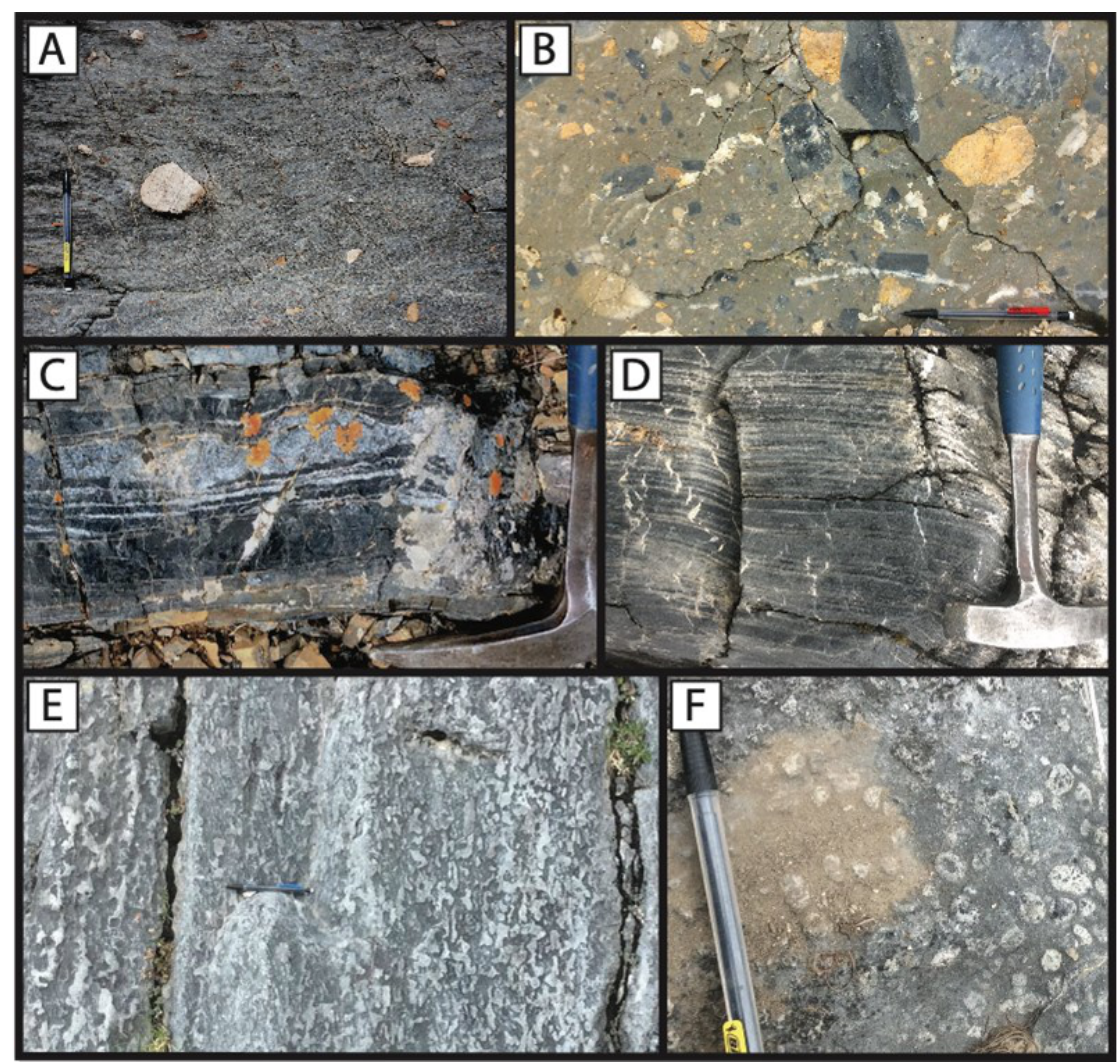
Fig. 4. Khuvsgul Group rocks in outcrop and hand-sample. A: Matrix-supported diamictite of the Ongolog Formation, featuring sub-angular to sub-rounded carbonate and granitic clasts. B: Yellow, dolomite-matrix- supported diamictite of the Shar Formation, with angular to sub-angular carbonate clasts, many of which are lithologically similar to strata of the underlying Bakh Formation. C: phosphorite of the lower phosphatic units of the Kheseen Formation observed in EA1701, with discontinuous layers of primary phosphatic material weathering blue-white between darker chert and limestone beds. D: Dolomite grainstones of the Kheseen Formation bearing phosphatic allochems, EA1814. E: Bed-penetrating bioturbation within grainstones of the Middle Member of the Erkhelnuur Formation. F: Archaeocyathid hash in grainstones of the Middle Member of the Erkhelnuur